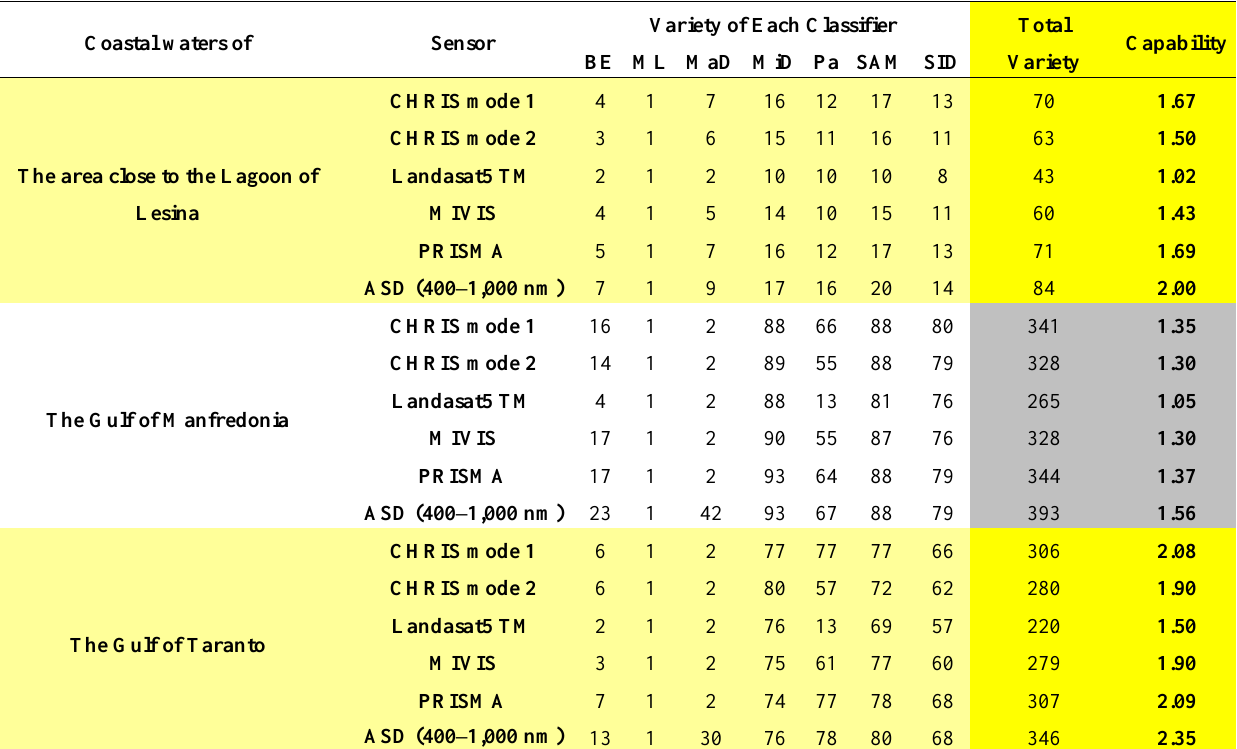
Table 4. The varieties of the spectral similarity measurements, extracted by each classifier for each site, are shown. These varieties were obtained on the CHRIS mode 1 and mode 2, the Landsat5-TM, the MIVIS, the PRISMA and the ASD, resized from 400 to 1,000 nm, data. In the last two columns, the total variety of the spectral similarity measurements and the capability are